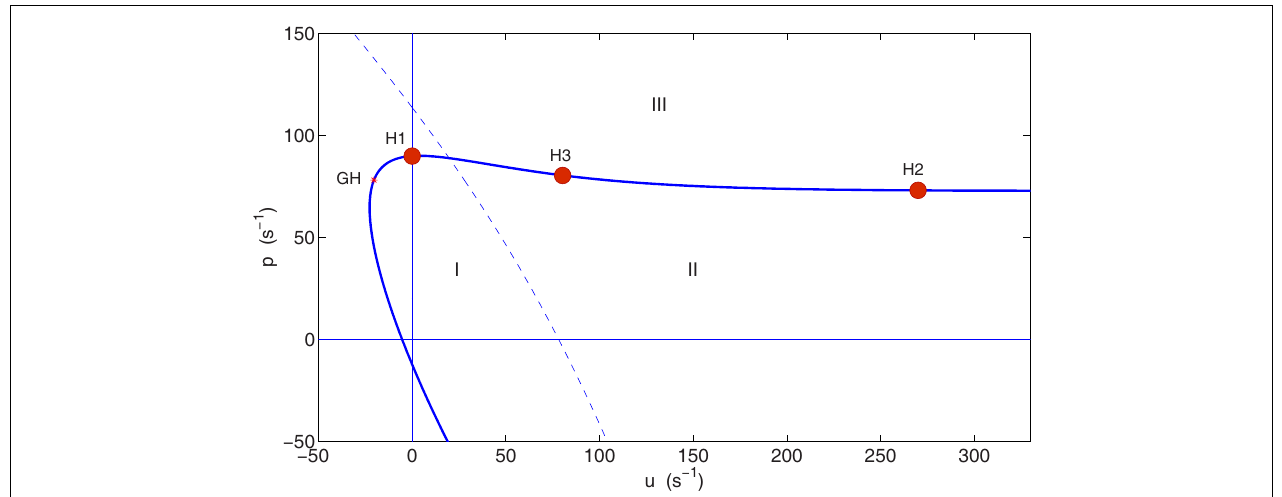
I and II) a stable fixed point exists, which gradually loses linear stability as the curve is approached. Above the Hopf curve (region III) this point has lost linear stability and become a stable limit cycle.The dashed line is a curve of fold bifurcation points. In region II a single stable fixed point exists. In region I the system is bistable with a second stable fixed point also existing, at lower excitation.